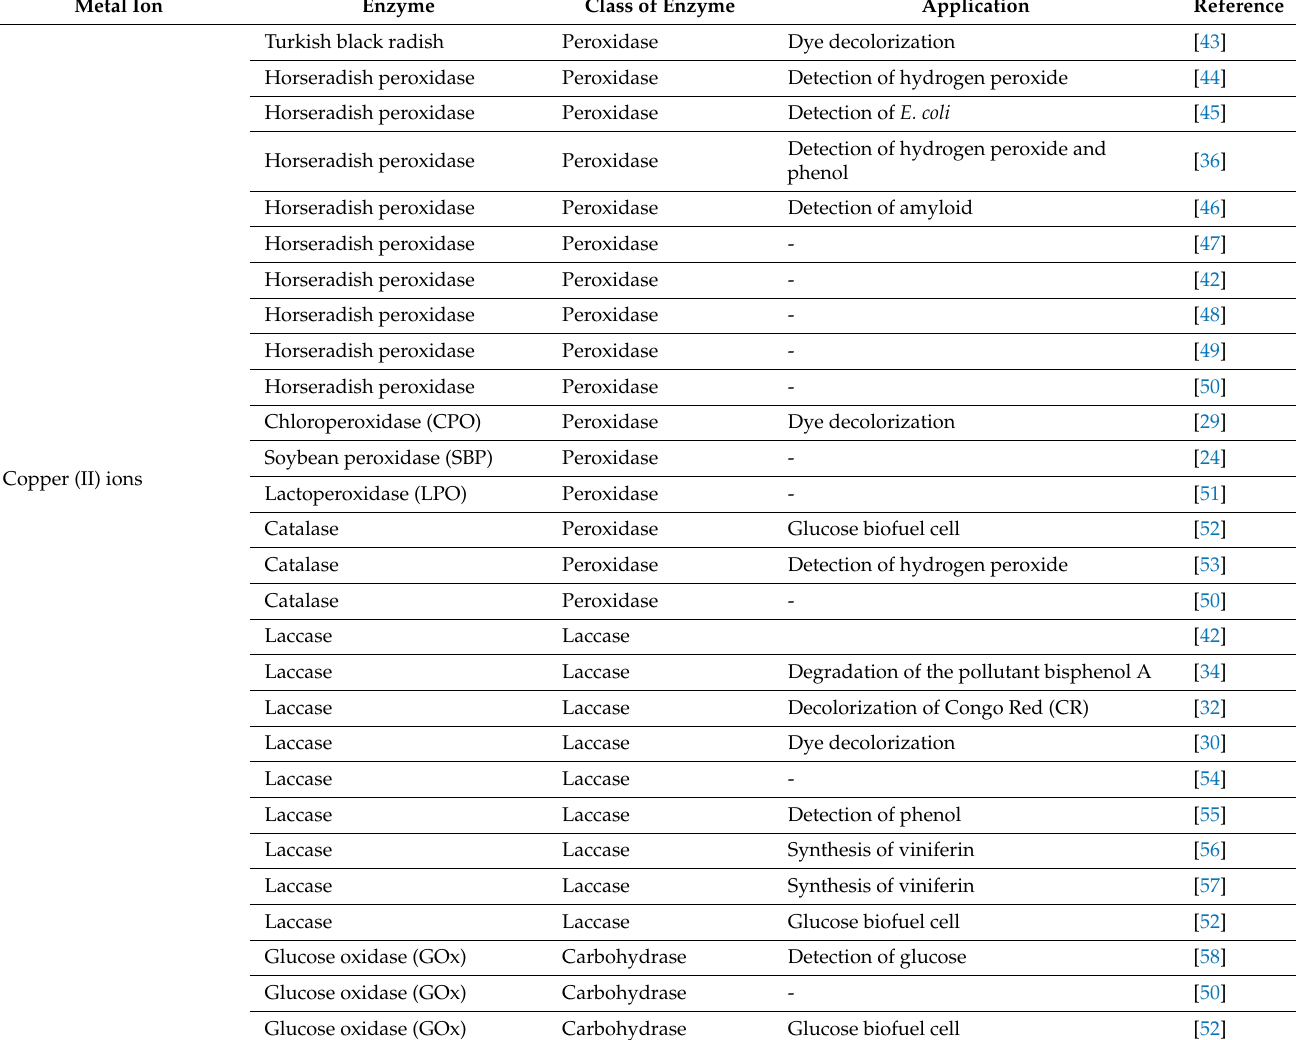
Table 1. Different hNFs based on the different metal ions and enzymes used. Metal Ion Enzyme Class of Enzyme